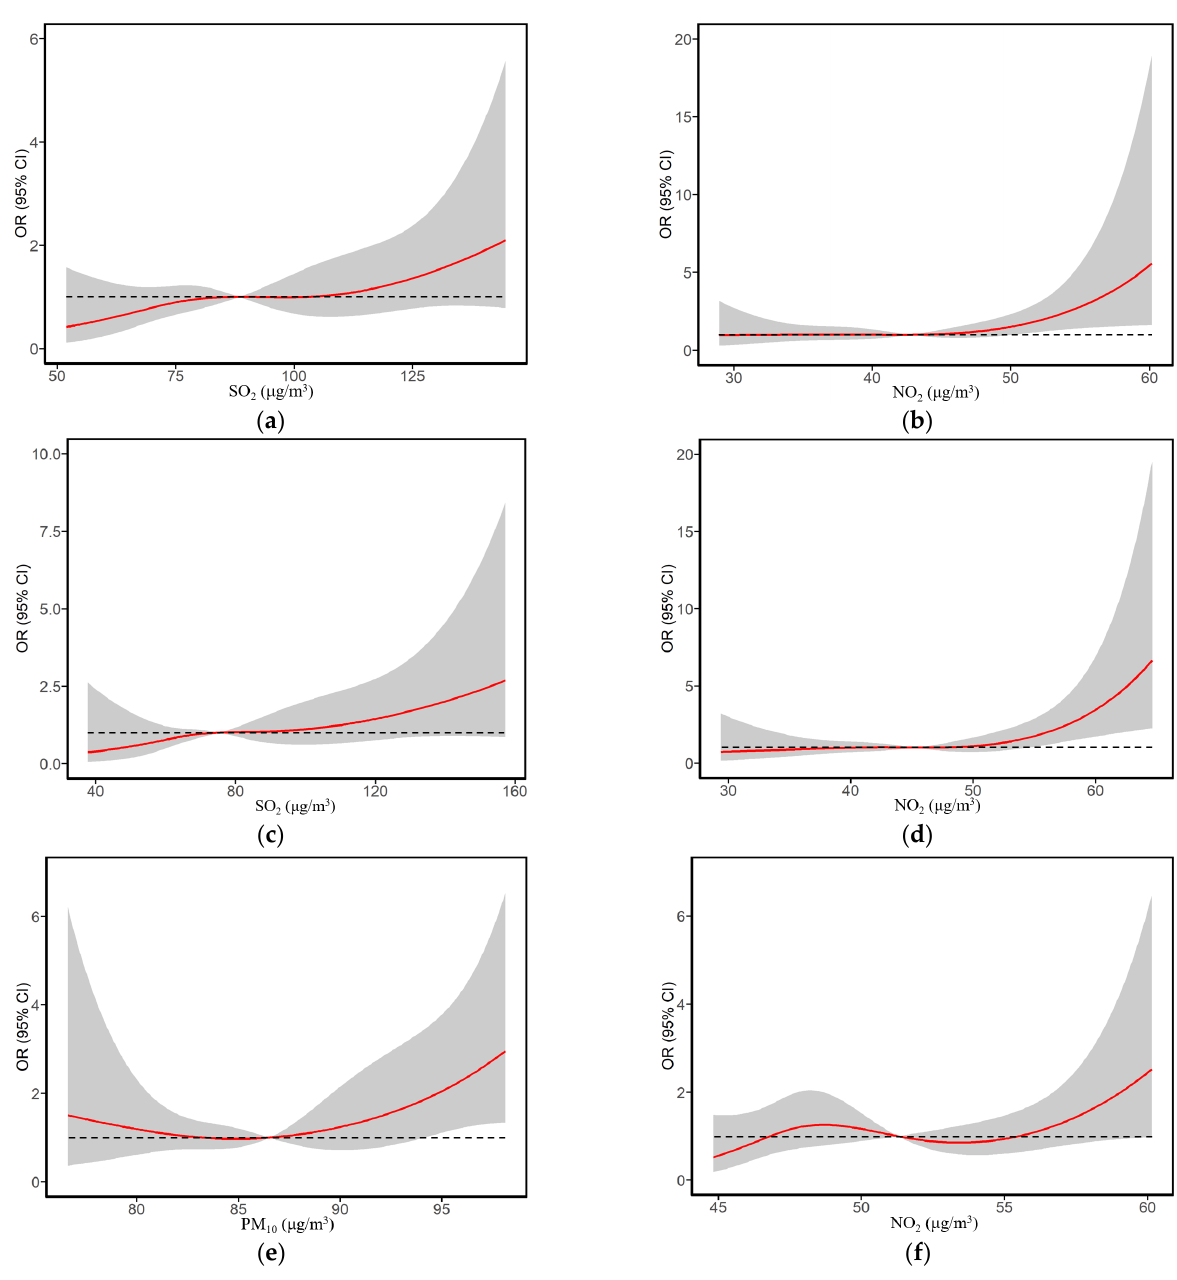
Figure 2. Concentration–response curves between exposure to PM 10 , SO 2 , and NO 2 during time windows and risks of childhood autumn SAR to pollen. OR (95% CI) was adjusted for all the covariates in Table 1. ( a ) One year before conception SO 2 . ( b ) One year before conception NO 2 . ( c ) Entire pregnancy SO 2 . ( d ) Entire pregnancy NO 2 . ( e ) Current PM 10 . ( f ) Current NO 2 . We found that prenatal and postnatal exposure to window condensation were sig- nificantly associated with childhood SAR to pollen, with adjusted ORs (95% CI) = 1.37 (1.05–1.77) and 1.38 (1.02–1.88) (Table 4), respectively. We further found a significant associ- ation between exposure to visible mold/damp stains during prenatal period and SAR to pollen in children, with a crude OR (95% CI) = 1.41 Table 4. Odds ratio (95% CI) of childhood annual SAR to pollen for exposure to indoor environ- mental factors during prenatal and postnatal periods ( n = 2598).